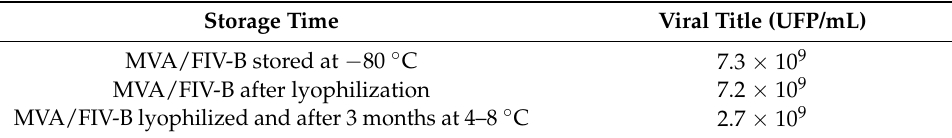
Table 1. Title of lyophilized and nonlyophilized MVA/FIV-B